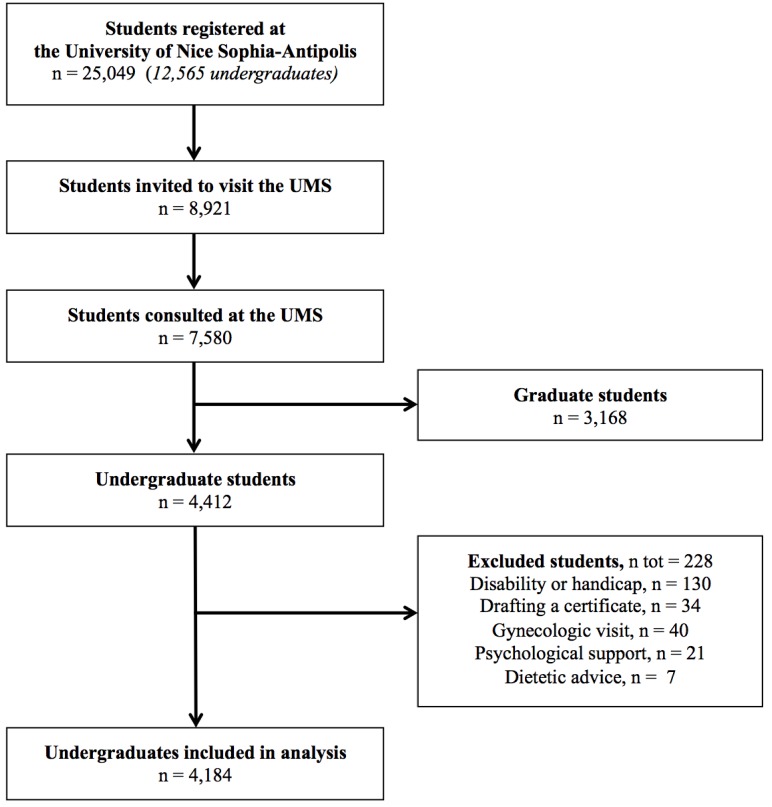
Study flow chart during the academic year 2012–2013.